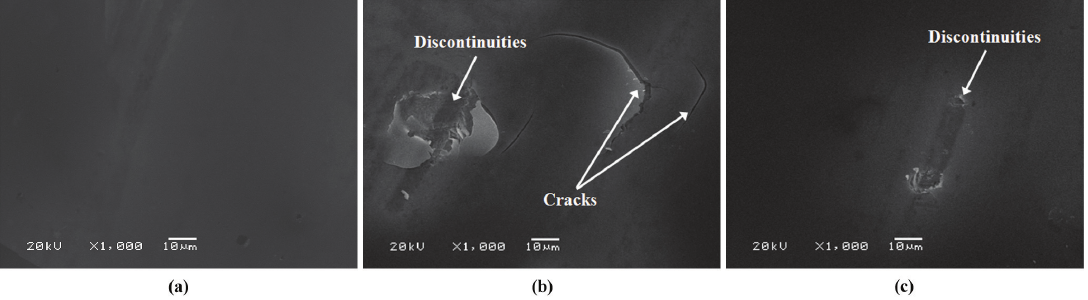
Figure 3. Micrographs obtained by SEM for the samples: (a) acetic acid, (b) hydrochloric and (c) nitric acid.